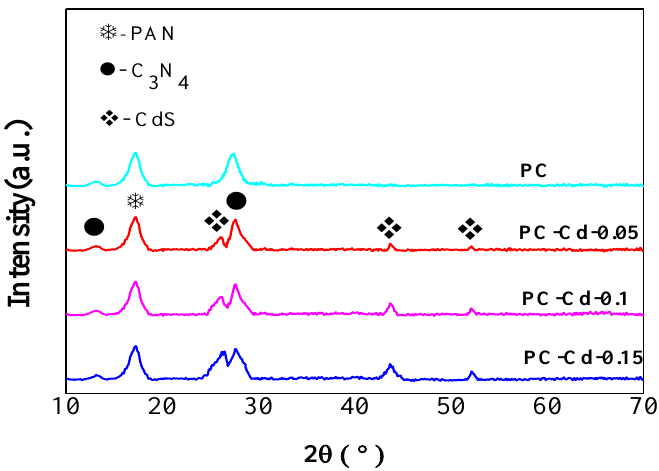
Figure 2. XRD spectra of PAN/g-C 3 N 4 with different concentration of CdS.